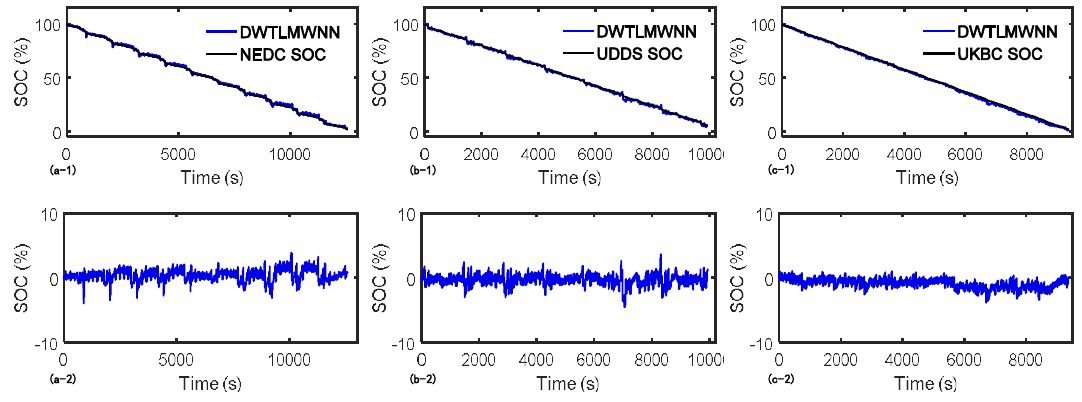
Figure 8. SOC estimation and SOC error under: ( a–1 , a–2 ) NEDC (trained), ( b–1 , b–2 ) UDDS (trained), and ( c–1 , c–2 ) UKBC (untrained). Table 4. Mean and maximum SOC error of DWTLMWNN and EKF under NEDC, UDDS, and UKBC. Driving Cycles